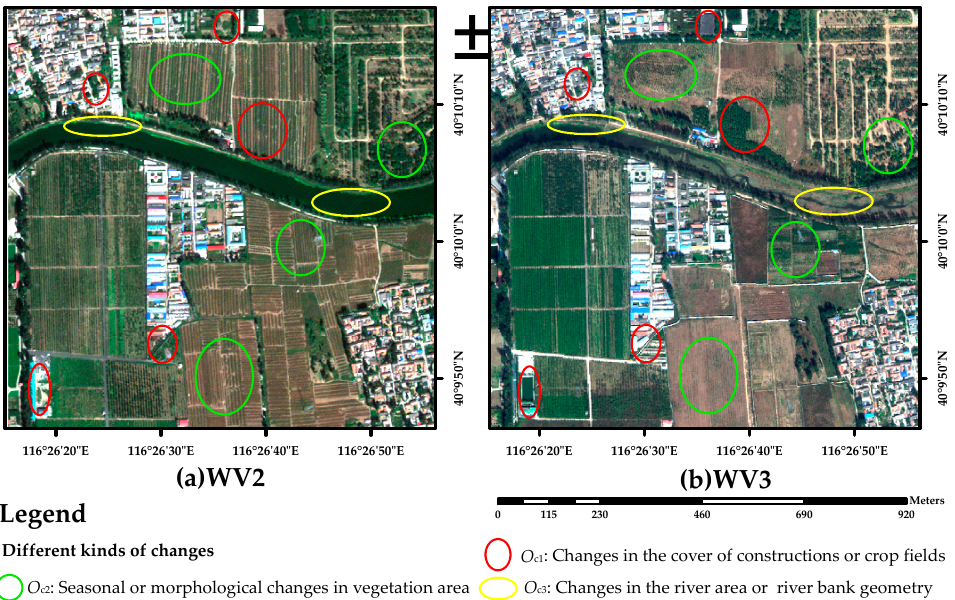
Figure 3. True color synthesis of images of study area nearby the Modern Agricultural Demonstrative Garden of Beijing (China) acquired by Worldview-2/3 VHR multispectral sensor on ( a ) 27 September 2010 and ( b ) 20 October 2014.